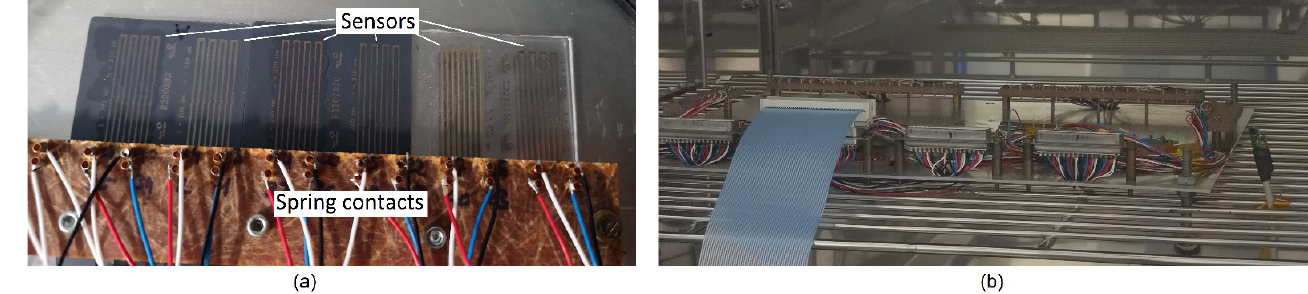
Figure 2. Temperature sensors connected with spring contacts ( a ) for tests in the climate chamber ( b ).